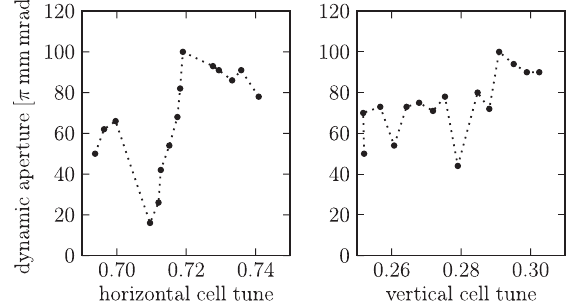
FIG. 8. Dynamic aperture vs (left) horizontal cell tune ( (cid:4) ). The optimized lattice of rectangu- (right) vertical cell tune ( (cid:4) y lar shaped magnets with polynomial fit to strength is used.